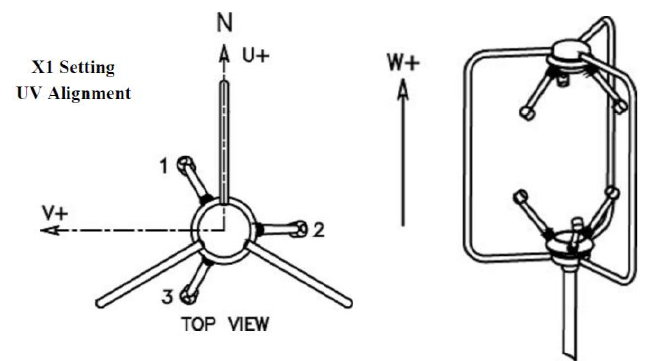
Figure 3. Configuration of the 3D sonic anemometer